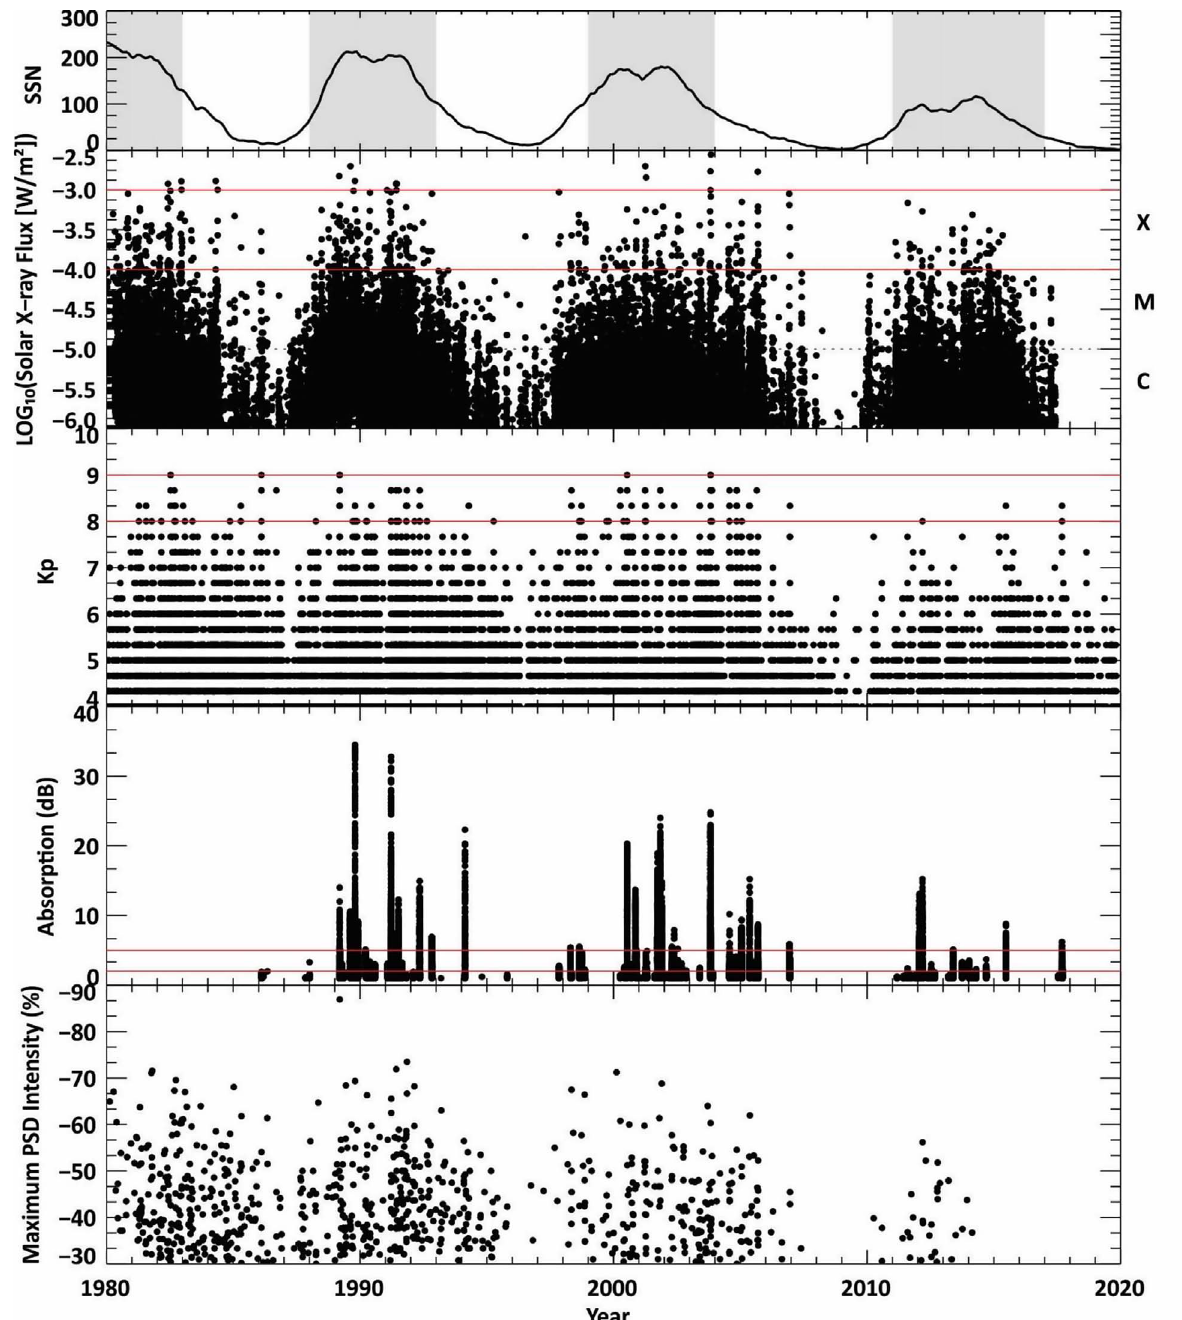
Fig. 2. (a) The 13-month smoothed mean total sunspot number. Grey shading indicates solar maximum years. Occurrence of (b) solar X-ray fl 1986 – 2020. Red horizontal lines indicate MOD and SEV event thresholds for (b) SWF (X1 and X10 solar X-ray fl are), (c) AA (Kp = 8, 9), and (d) PCA (2 dB and 5 dB absorption at 30 MHz). (e) Maximum intensity of PSD events, represented by hourly relative